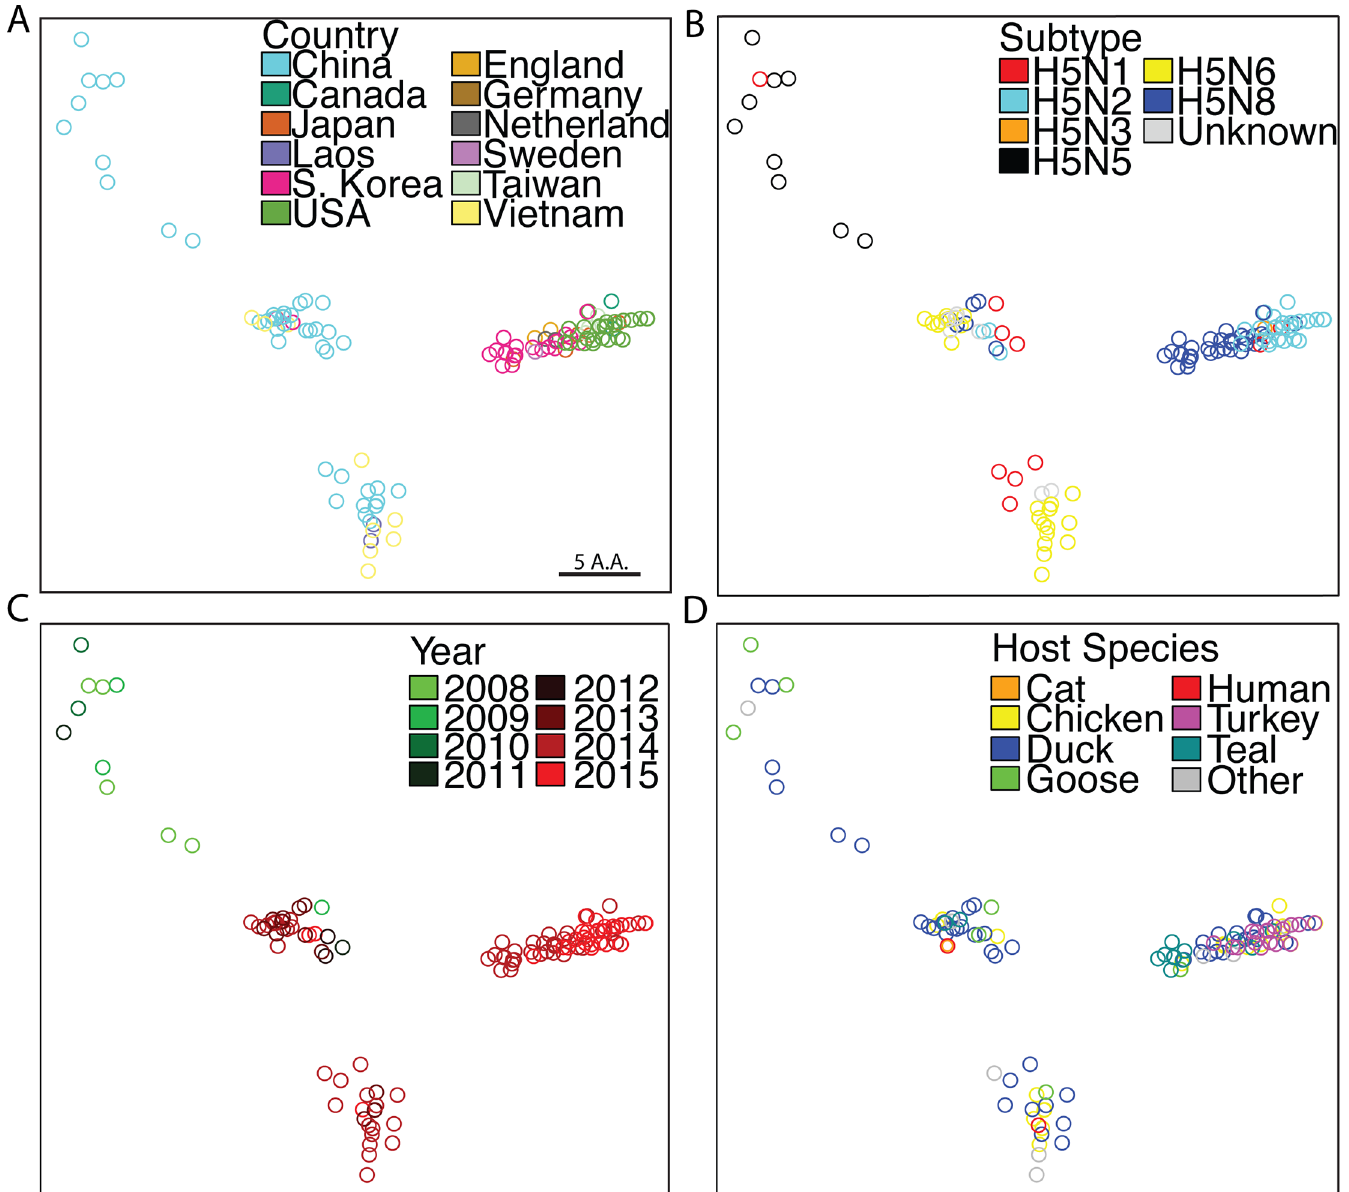
Fig 2. SBM Analysis of clade 2.3.4.4 H5NX viruses. SBM analysis restricted to virus HA sequences belonging to clade 2.3.4.4. (A) HA sequences colored by country of isolation. (B) Sequences colored by NA subtype. (C) Sequences colored by year of isolation as a continuum from green to red (2008 – 2015 respectively). (D) Sequences colored by species in which virus was